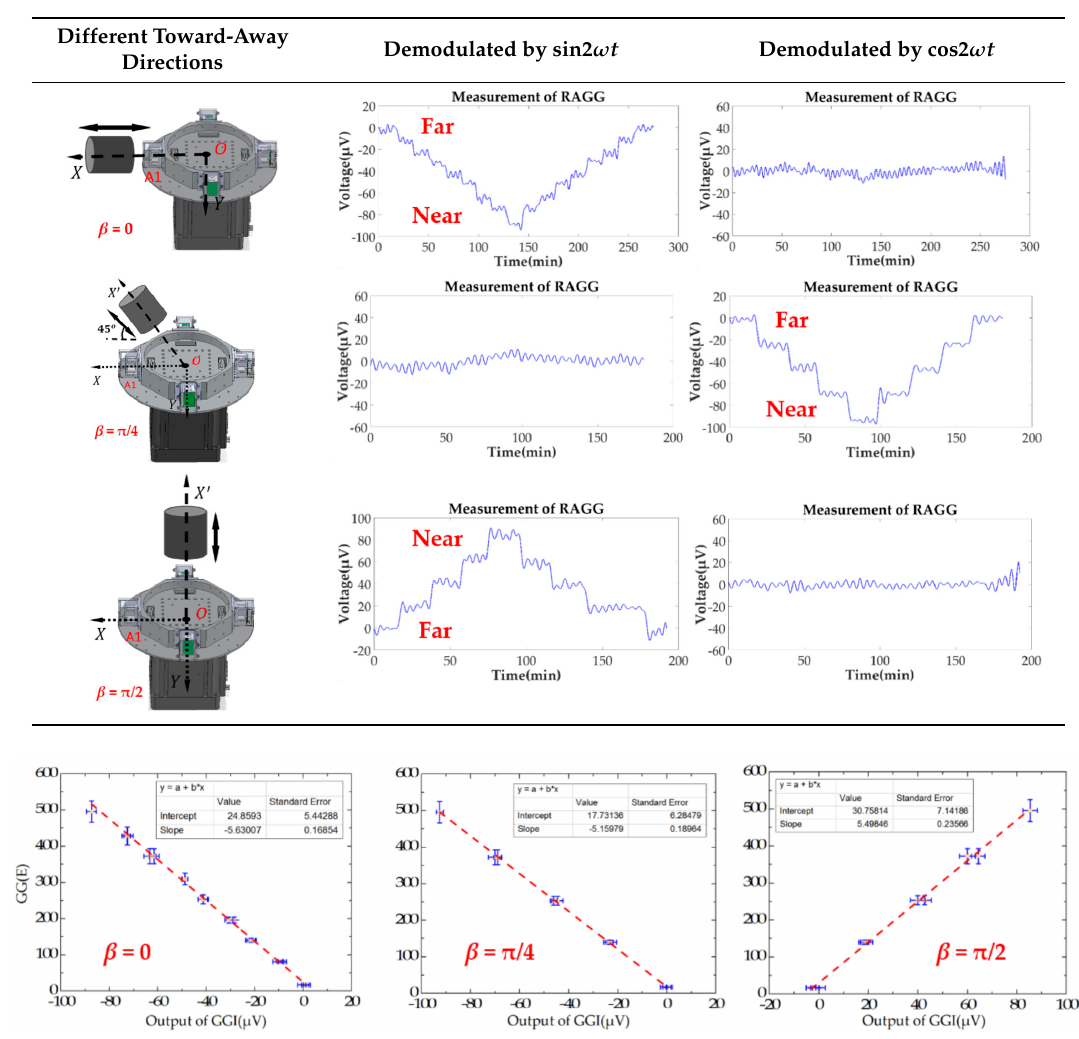
Figure 8. Fitting curve of scale factor of static-platform state calibration of the